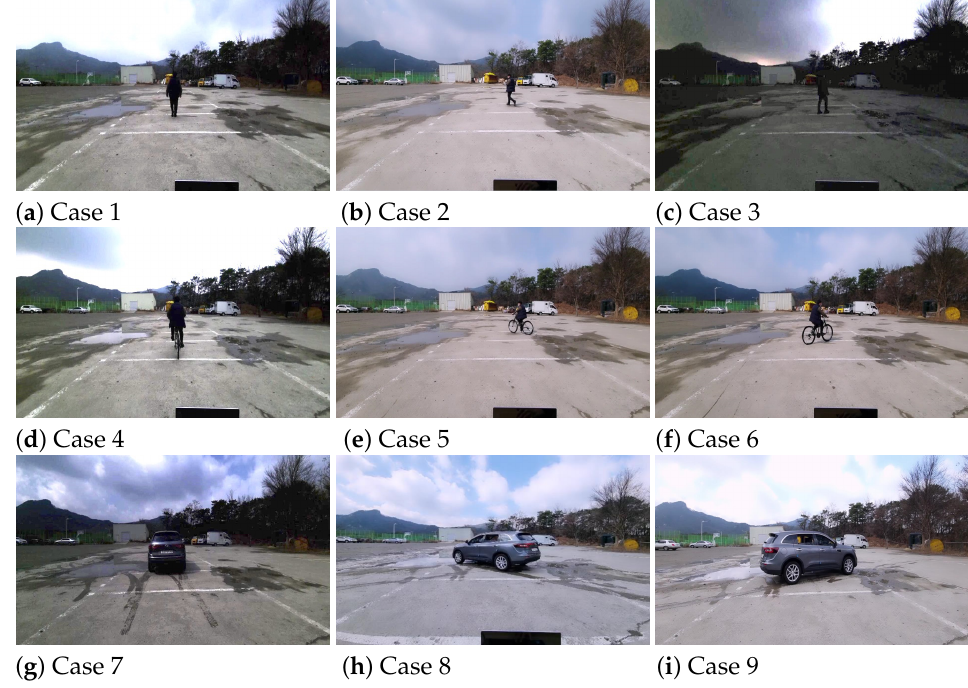
Figure 4. Radar signal measurements in the test field: Cases 1 to